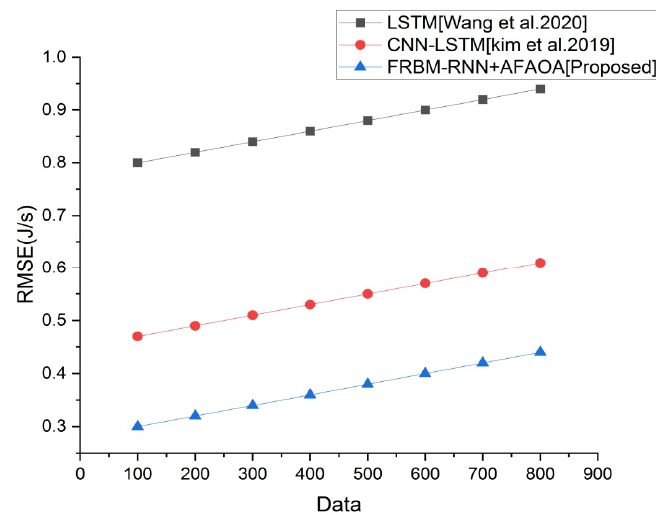
Figure 5. Graphical analysis of different models based on MSE [Source: Author].